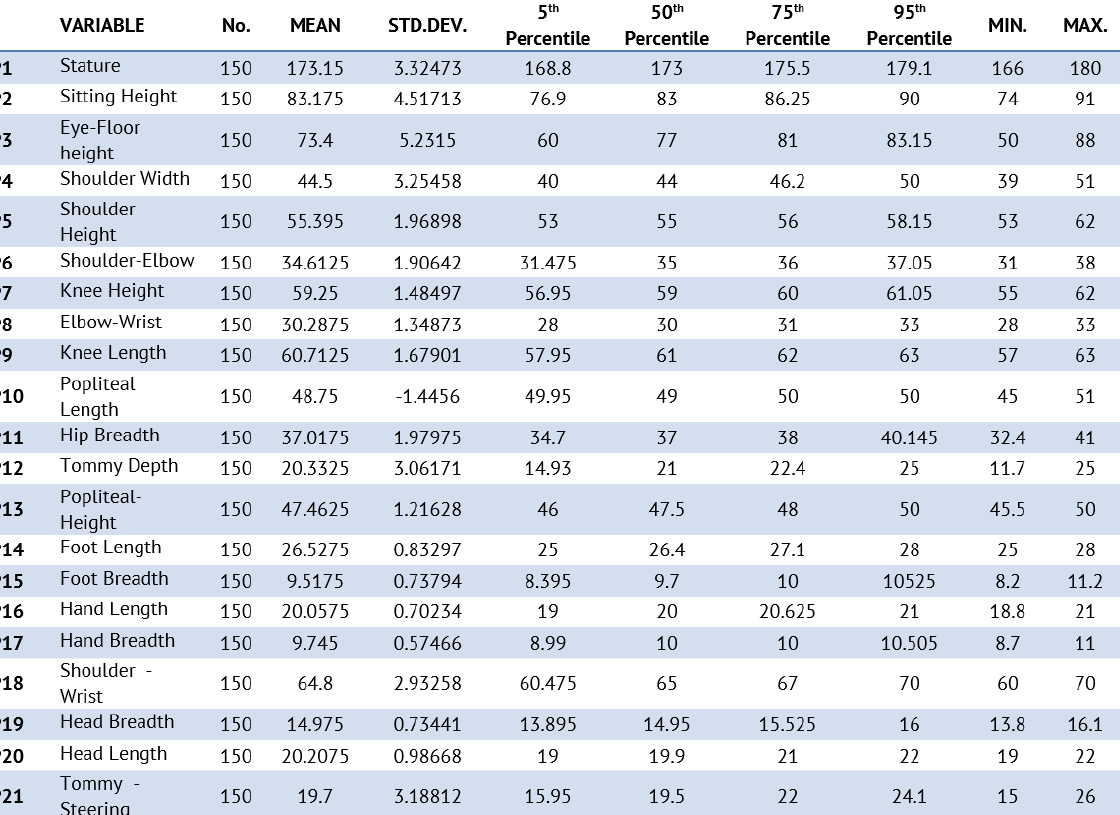
Summary of the Anthropometric Dimensions of 150 Nigerian Male Urban Bus Drivers Length/Height (cm), Angles